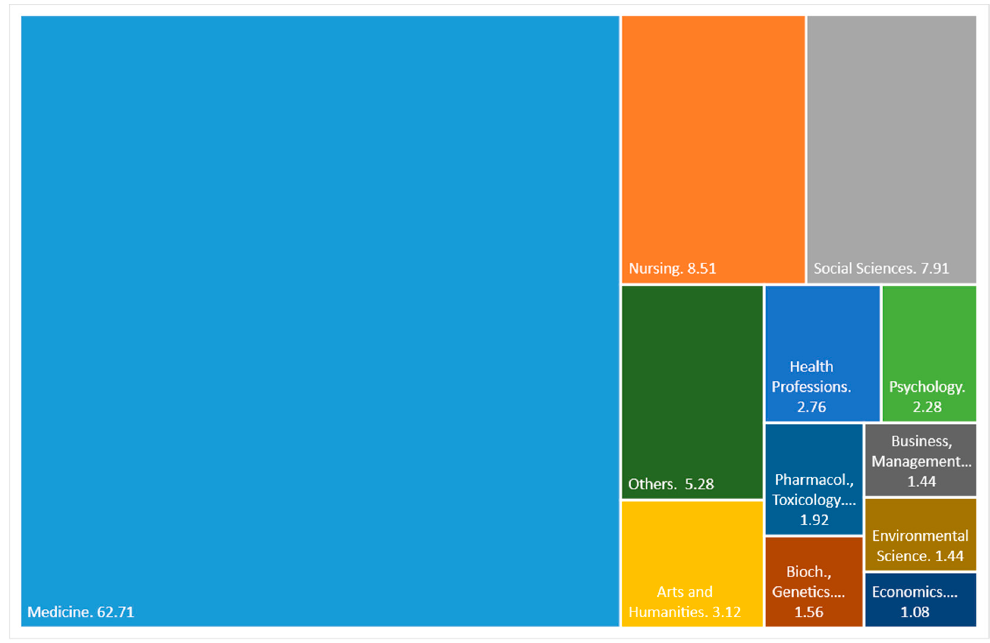
Figure 3. Documents by subject area (percentage).